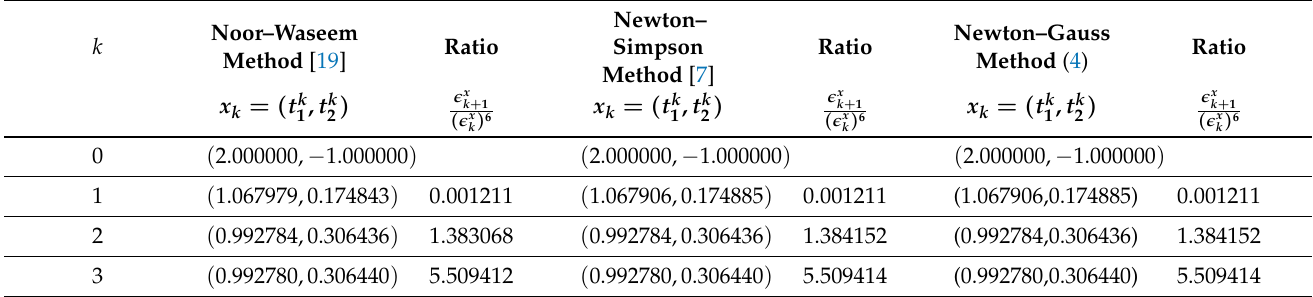
Table 3. Methods of order 6.